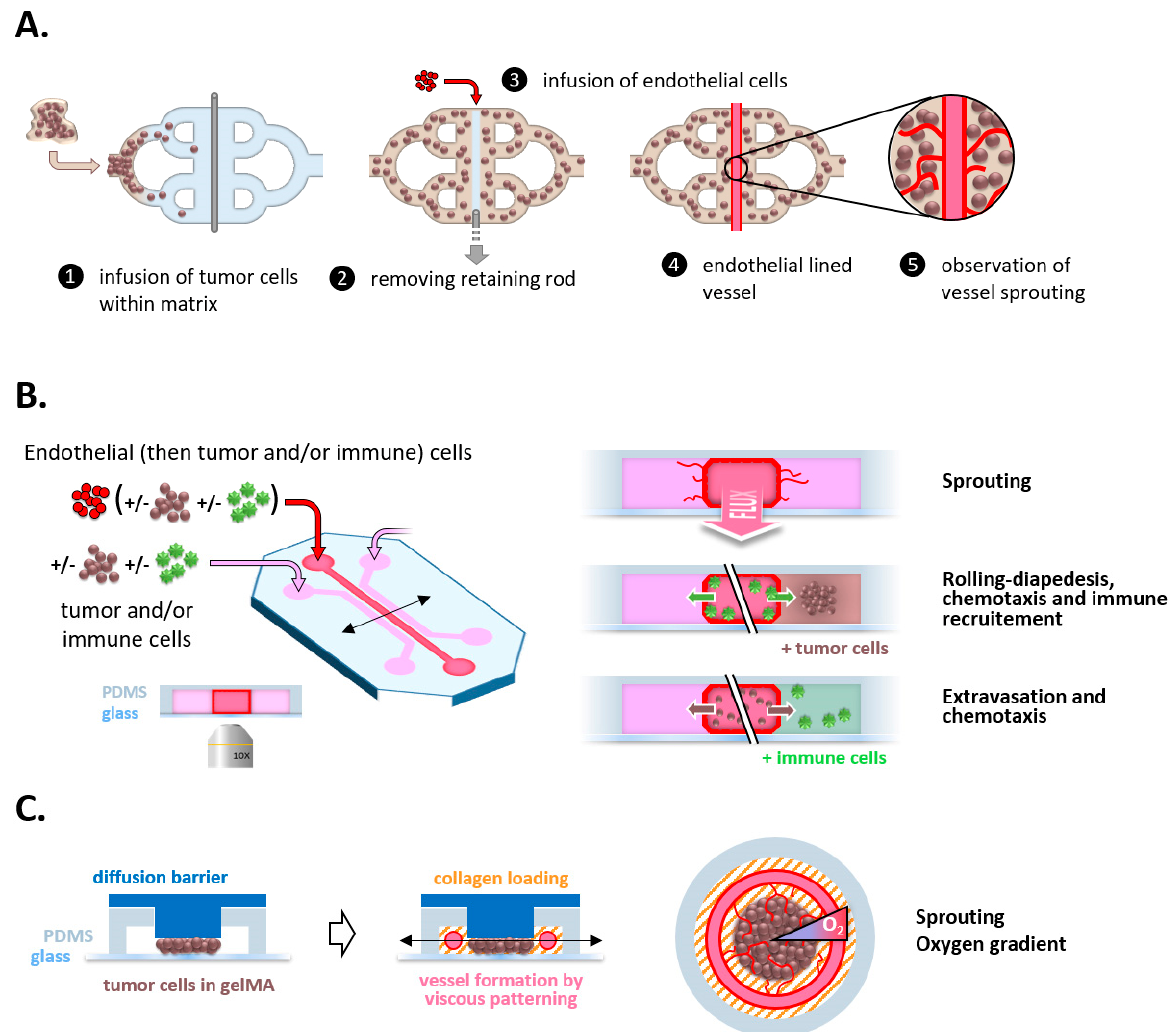
Figure 3. Chips shed light on the multiple facets of tumor angiogenesis and immunity. ( A ) Vascular channels can be generated by removing a needle from an ECM hydrogel. ( B ) PDMS molds classically permit generation of parallelized channels with their own reservoirs. This geometry allows investigation by microscopy of the impact upon angiogenesis of shear stress, paracrine interactions, chemotaxis, and extravasation events. ( C ) The generation of a radial oxygen gradient in a tumor disk permits deciphering of the interactions of a hypoxic tumor ‐ on ‐ chip with surrounding vessels and the recruitment of immune cells.